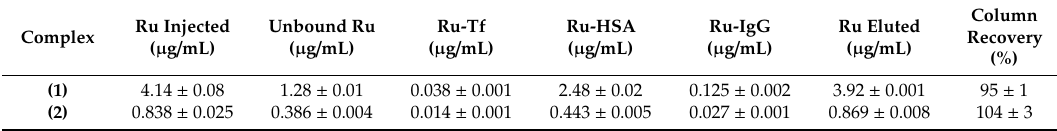
Table 1. Concentrations of Ru species in human serum spiked with complexes ( 1 ) or ( 2 ). Ru species were separated on CLC column and their concentration determined by ICP-MS, using post-column ID-ICP-MS. Column recovery was calculated as the ratio between the sum of concentrations of Ru species in the fractions eluted and the Ru concentration in spiked serum injected onto the column.